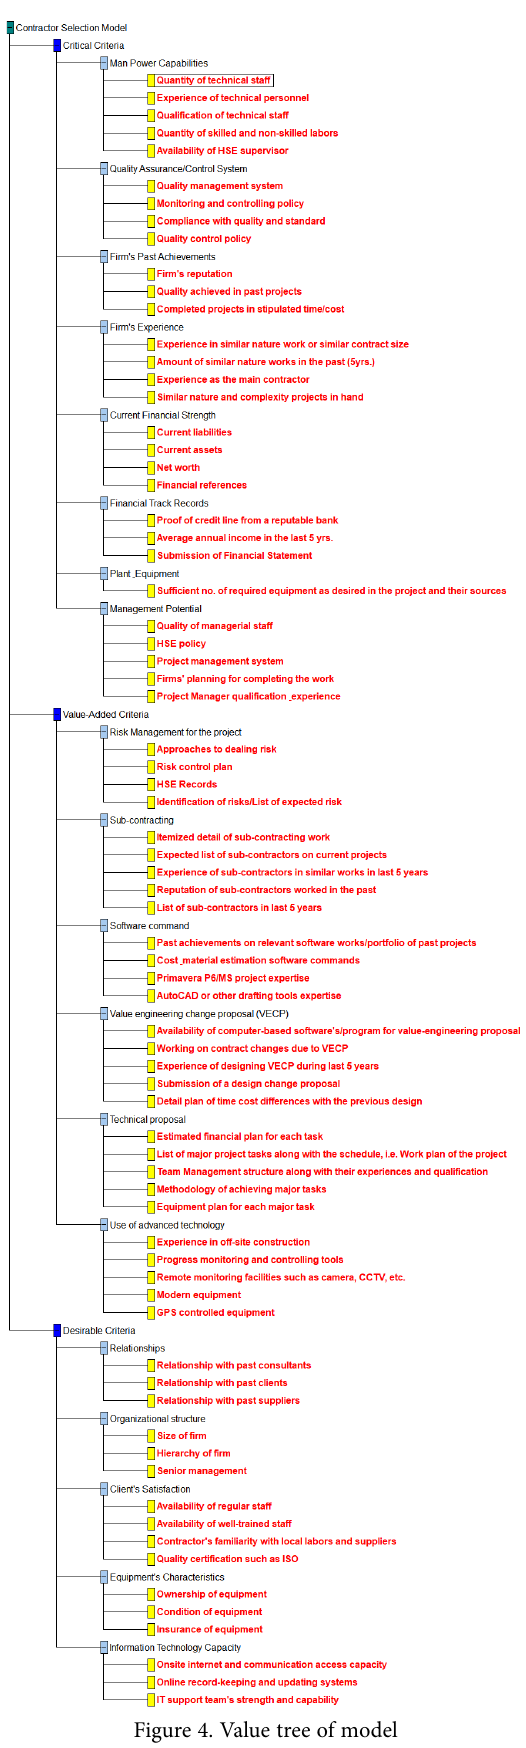
Figure 4. Value tree of model